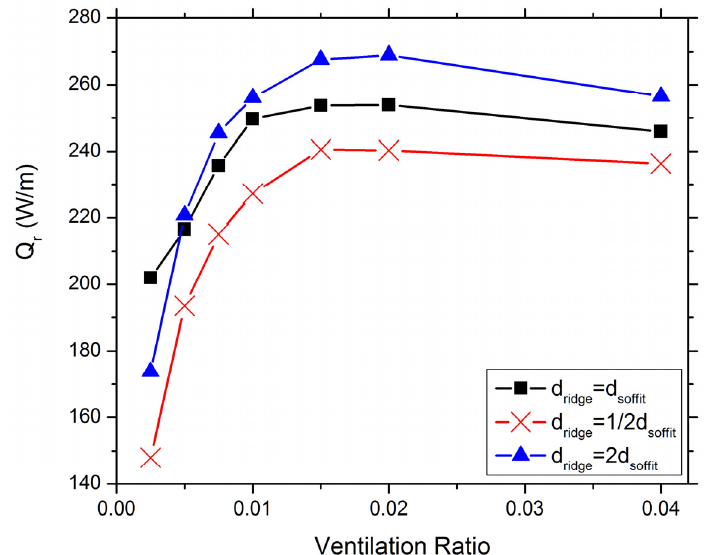
Figure 9. Predicted heat gain from roof as a function of ventilation ratio for balanced and unbalanced attic ventilation